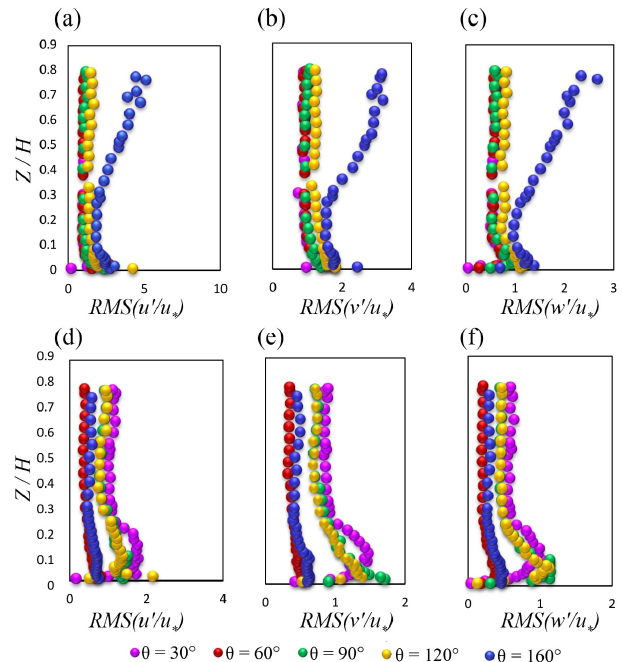
Figure 17. Turbulence intensity distributions in 3D at different azimuthal sections in the ( a – c ) channel bed without vegetation and ( d – f ) the channel bed with vegetation, at distances of 4 cm from the abutment.